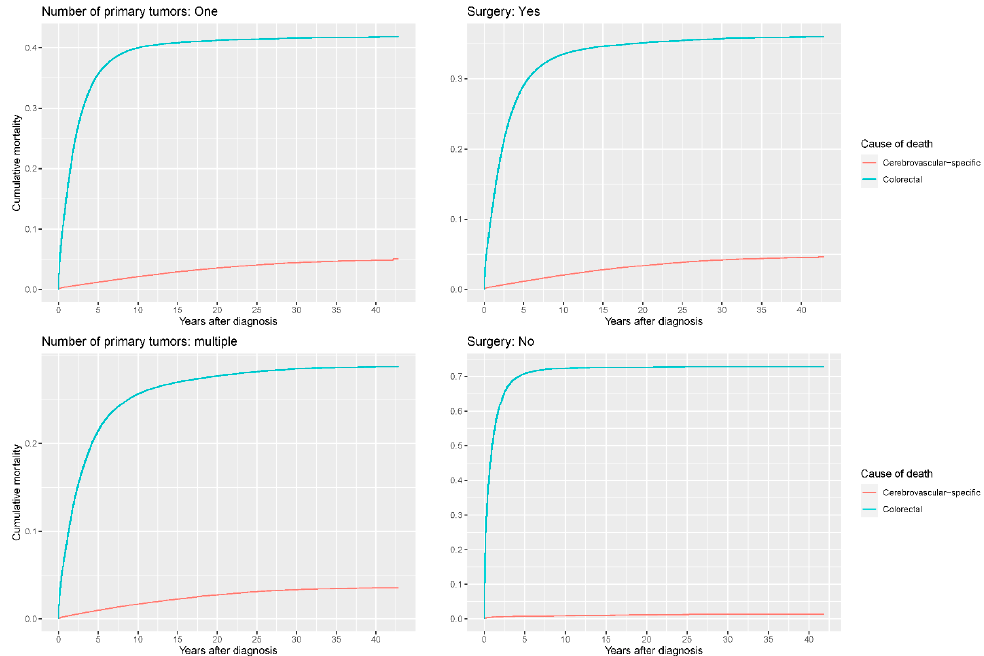
Figure 8. Cumulative cerebrovascular-specific and colorectal cancer-specific mortality stratified by number of primary tumors and surgery. Univariate analyses using a competing risk model were performed to test the relationship between these factors and CVSM in CRC patients ( p < 0.0001), and differences in cumulative mortality among different subgroups were analyzed by Gary’s test.